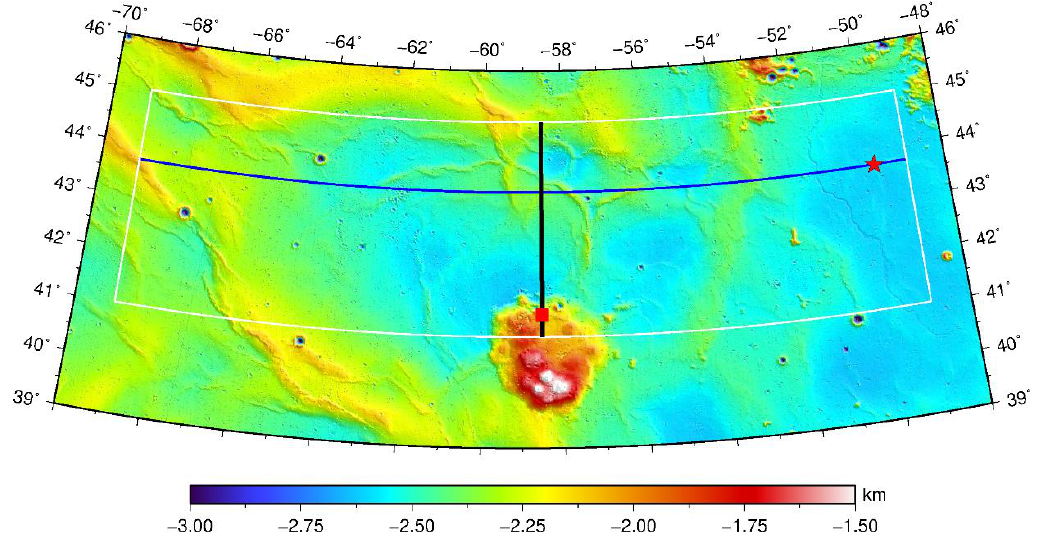
Figure 1. Elevation map of Rümker region, which is plotted with Lambert conformal conic projection. The elevation data comes from Lunar Orbiter Laser Altimeter (LOLA) Digital Elevation Model (DEM) models of LDEM_512_00N_45N_000_090.IMG, and LDEM_512_45N_90N_000_090.IMG. The white box signifies the candidate landing region of CE-5. The red star denotes the candidate landing site centered at (43.68°N, 49.85°W), the red box signifies the possible landing site centered at (41.41°N, 58.53°W). The blue and black lines are the longitude and latitude directions used to investigate temperature variation in Figure 8 and Figure 9, respectively.